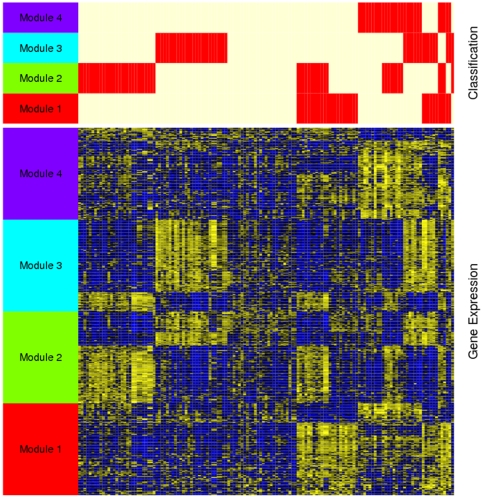
Four binary classifications of high grade ovarian serous cancer.The ISIS algorithm identified four independent binary partition classifications (splits) of 129 ovarian cancer samples. Each binary classification is supported by an independently selected set of 100 genes (module). The top panel of this figure shows four horizontal bars representing the classification of the 129 tumor samples (columns) with respect to the gene modules. Red indicates that a patient was classified into the smaller group resulting from the respective split (g1) and white indicates the classification into the larger group (g0). The heatmap in the lower panel represents the expression profiles of the gene modules supporting the four binary classifications. Each row represents a gene, each column a patient and each cell correspond to a gene and its expression level; yellow indicates an expression level of a gene above its mean across the patients and blue below its mean.